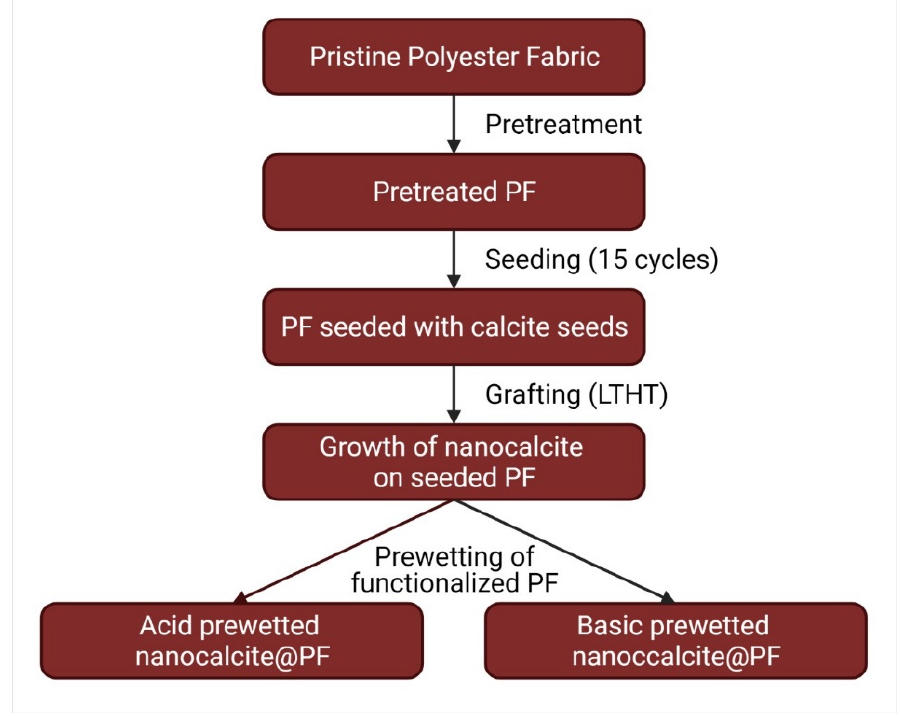
Figure 1. Flowchart of the fabrication of prewetted nanocalcite @ PF.